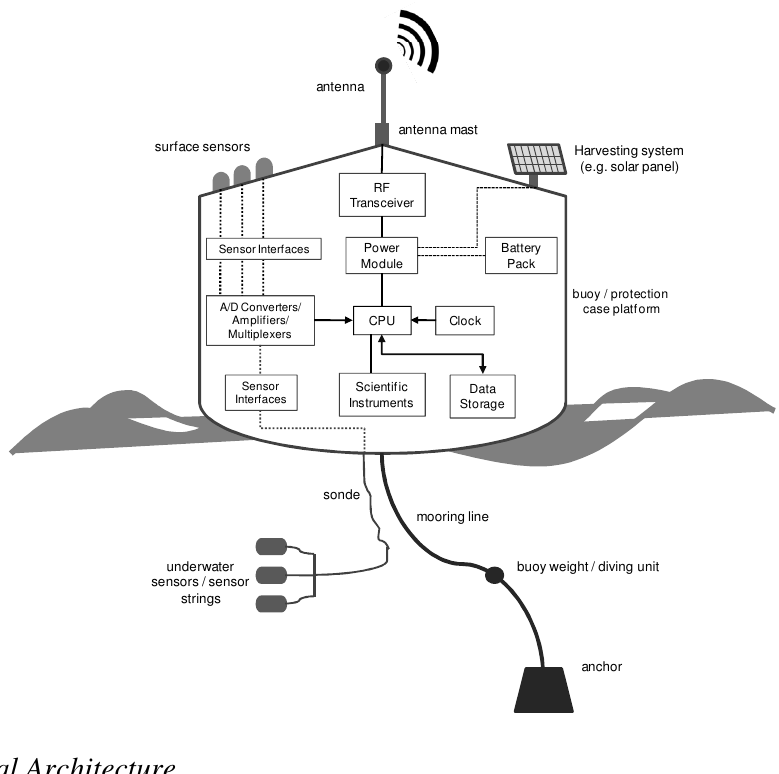
Figure 1. General scheme of a sensor node for oceanographic